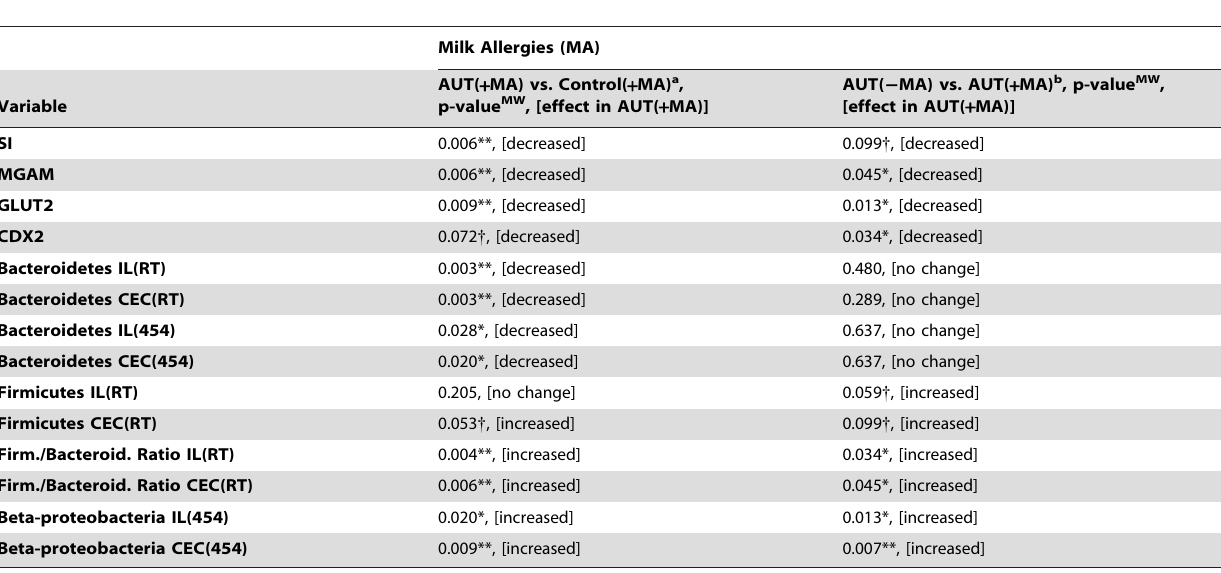
Table 6. Association of milk allergy (MA) with host gene expression and bacterial phylotypes in AUT-GI children.